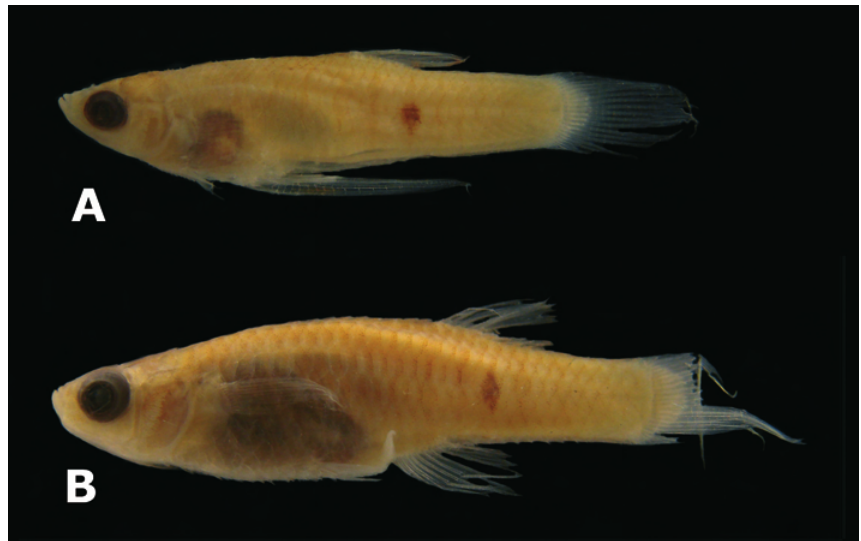
Fig. 32. Phalloceros alessandrae . (A) Holotype, male, 17.5 mm SL, MCP 30402, flooded areas on margins of road PR 340, Antonina, Paraná, Brazil; (B) paratype, female, MCP 25561, 22.1 mm SL, collected with the holotype.